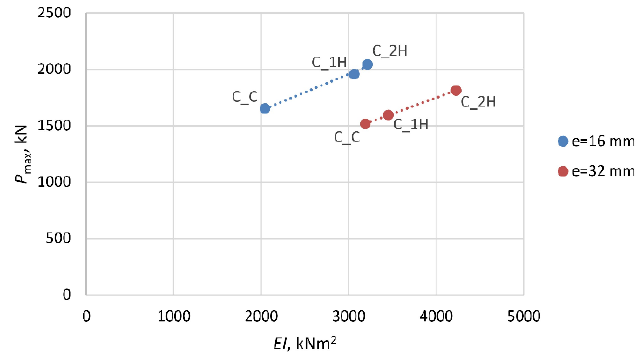
Figure 11. Change in stiffness of columns C_1H and C_2H as a function of failure load.